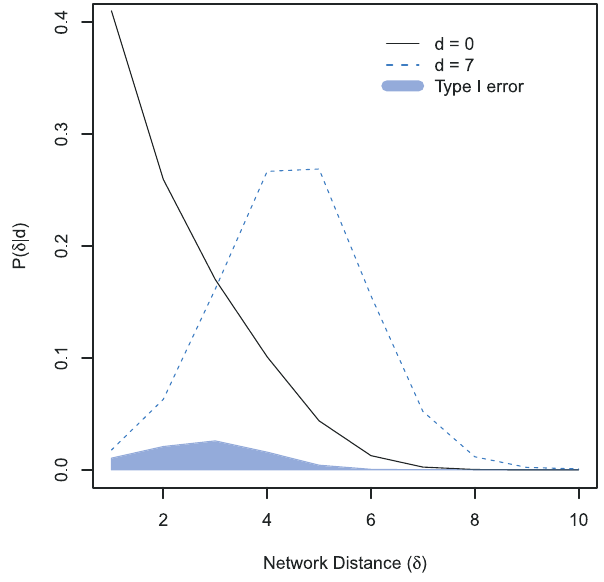
Figure 3. Likelihood for d , the number of nodes separating two individuals in the network, given that the number of discor- dant alleles in their isolates is d . The area of the shaded region is the probability that a pair of individuals with seven discordant alleles will be closer together in the network than a pair of individuals with no discordant alleles, the Type I error (see Methods, and Figure